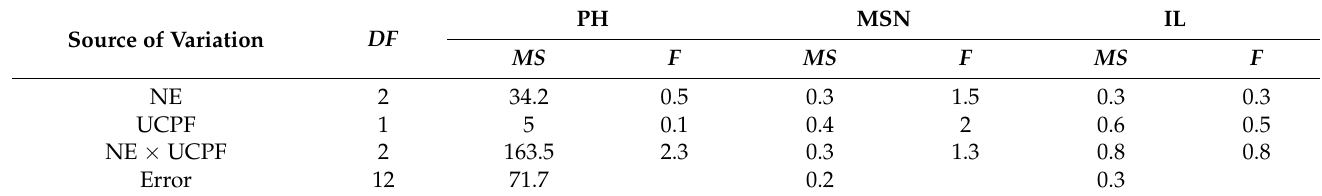
Table 6. Analysis of variance of soybean agronomic traits in autumn sowing net